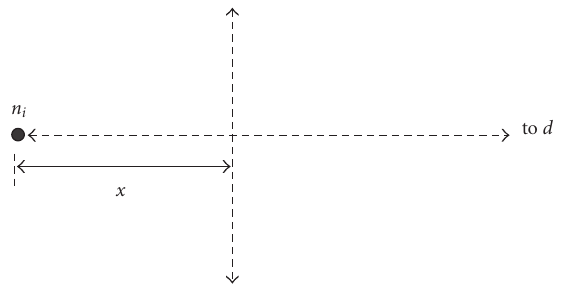
Figure 16: Calculation of p Λ ( x )